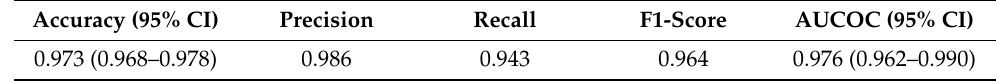
Table 3. Detection performance of PE from frontal chest X-rays.